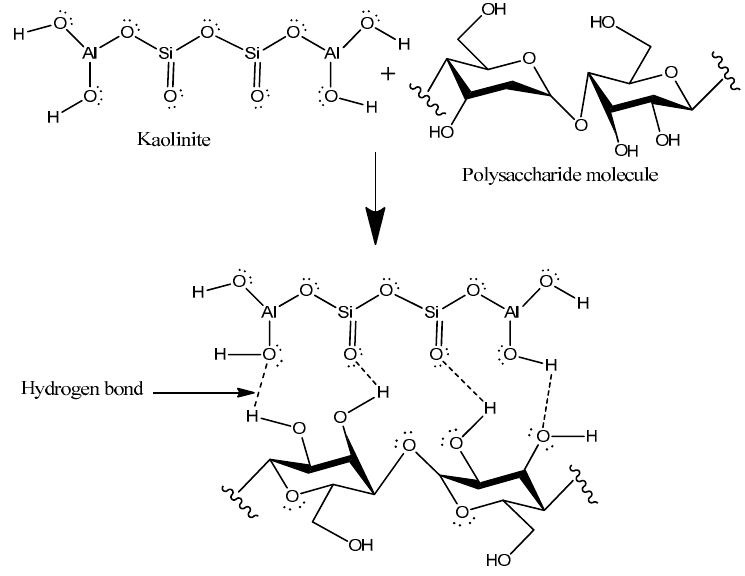
Figure 15. Formation of hydrogen bonds.